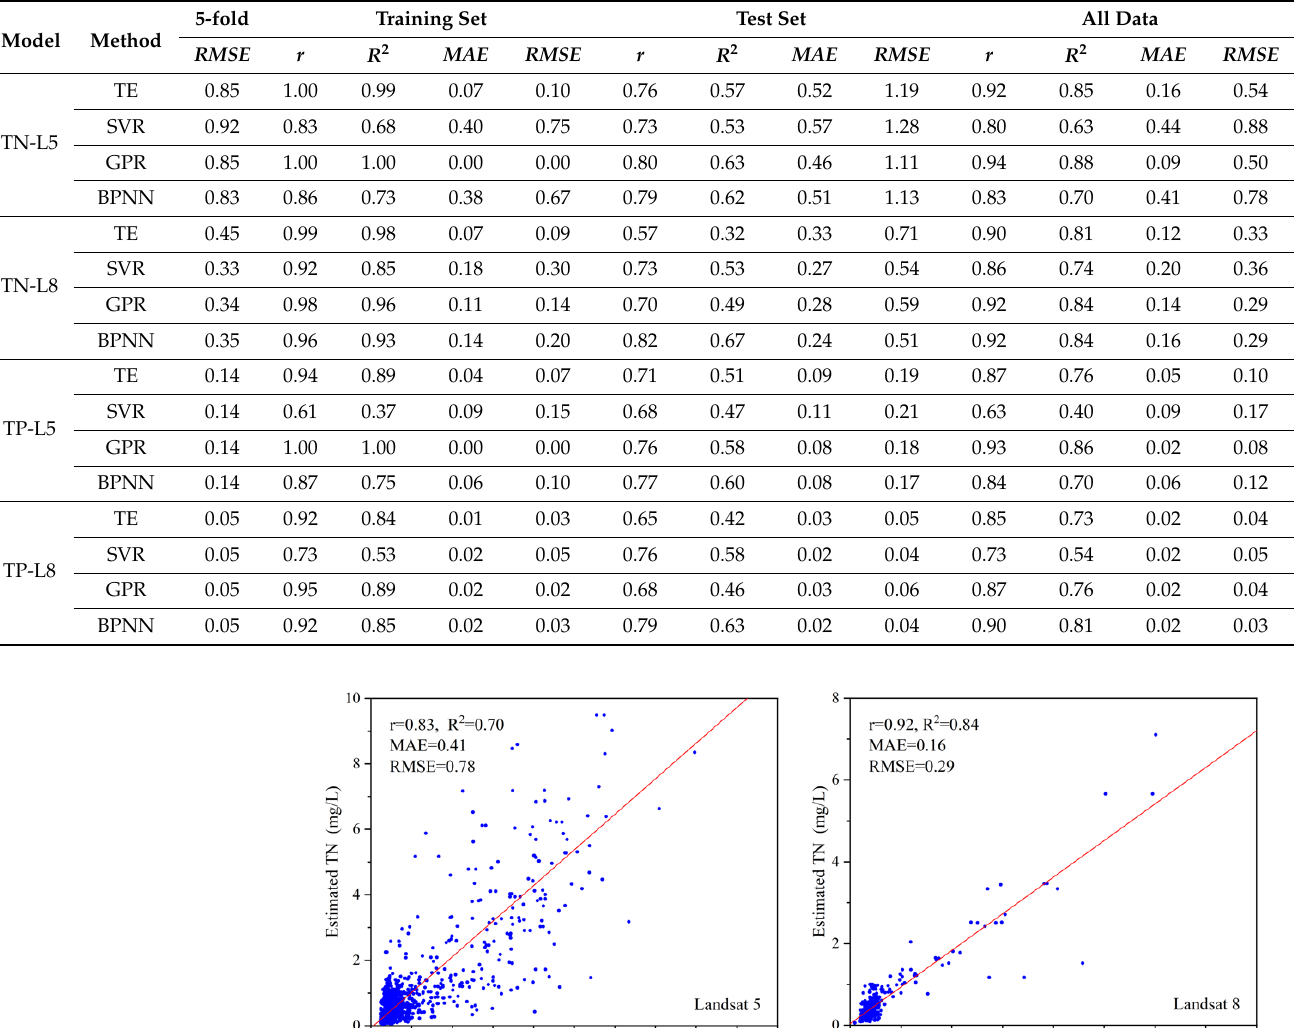
Table 2. Accuracy values of the TE, SVM, GPR and BPNN methods.